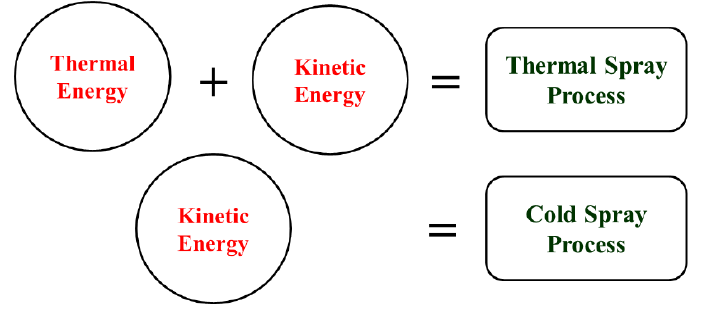
Figure 1. Sources of energy in a conventional thermal spray vs. cold gas dynamic spray process.